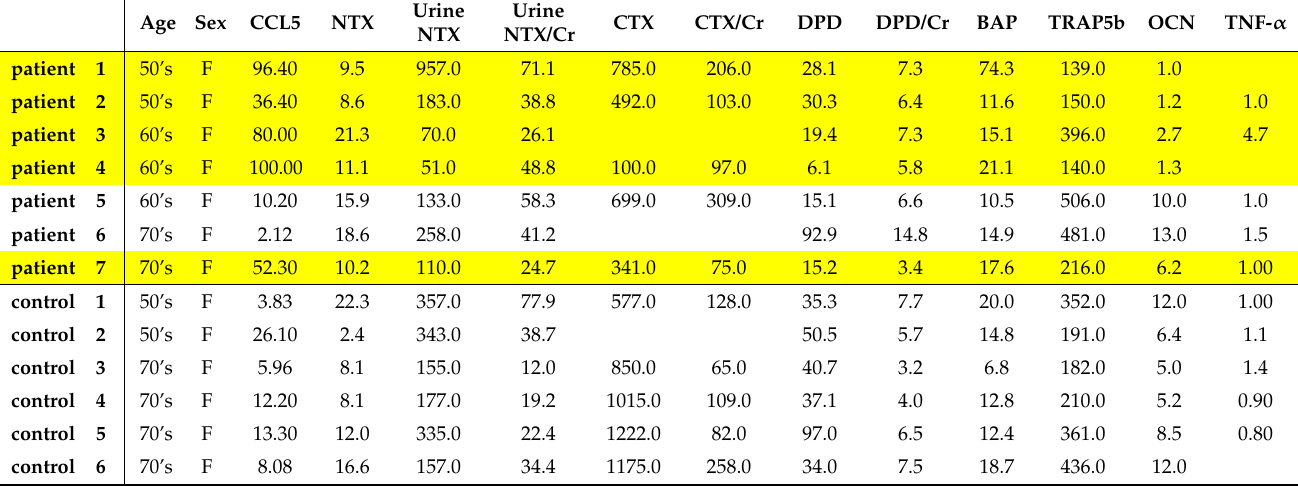
Table 3. The list of laboratory results for DJD-TMJ and control subjects at >42 years old (Older subjects). Highlighted in yellow shows patients with systemic